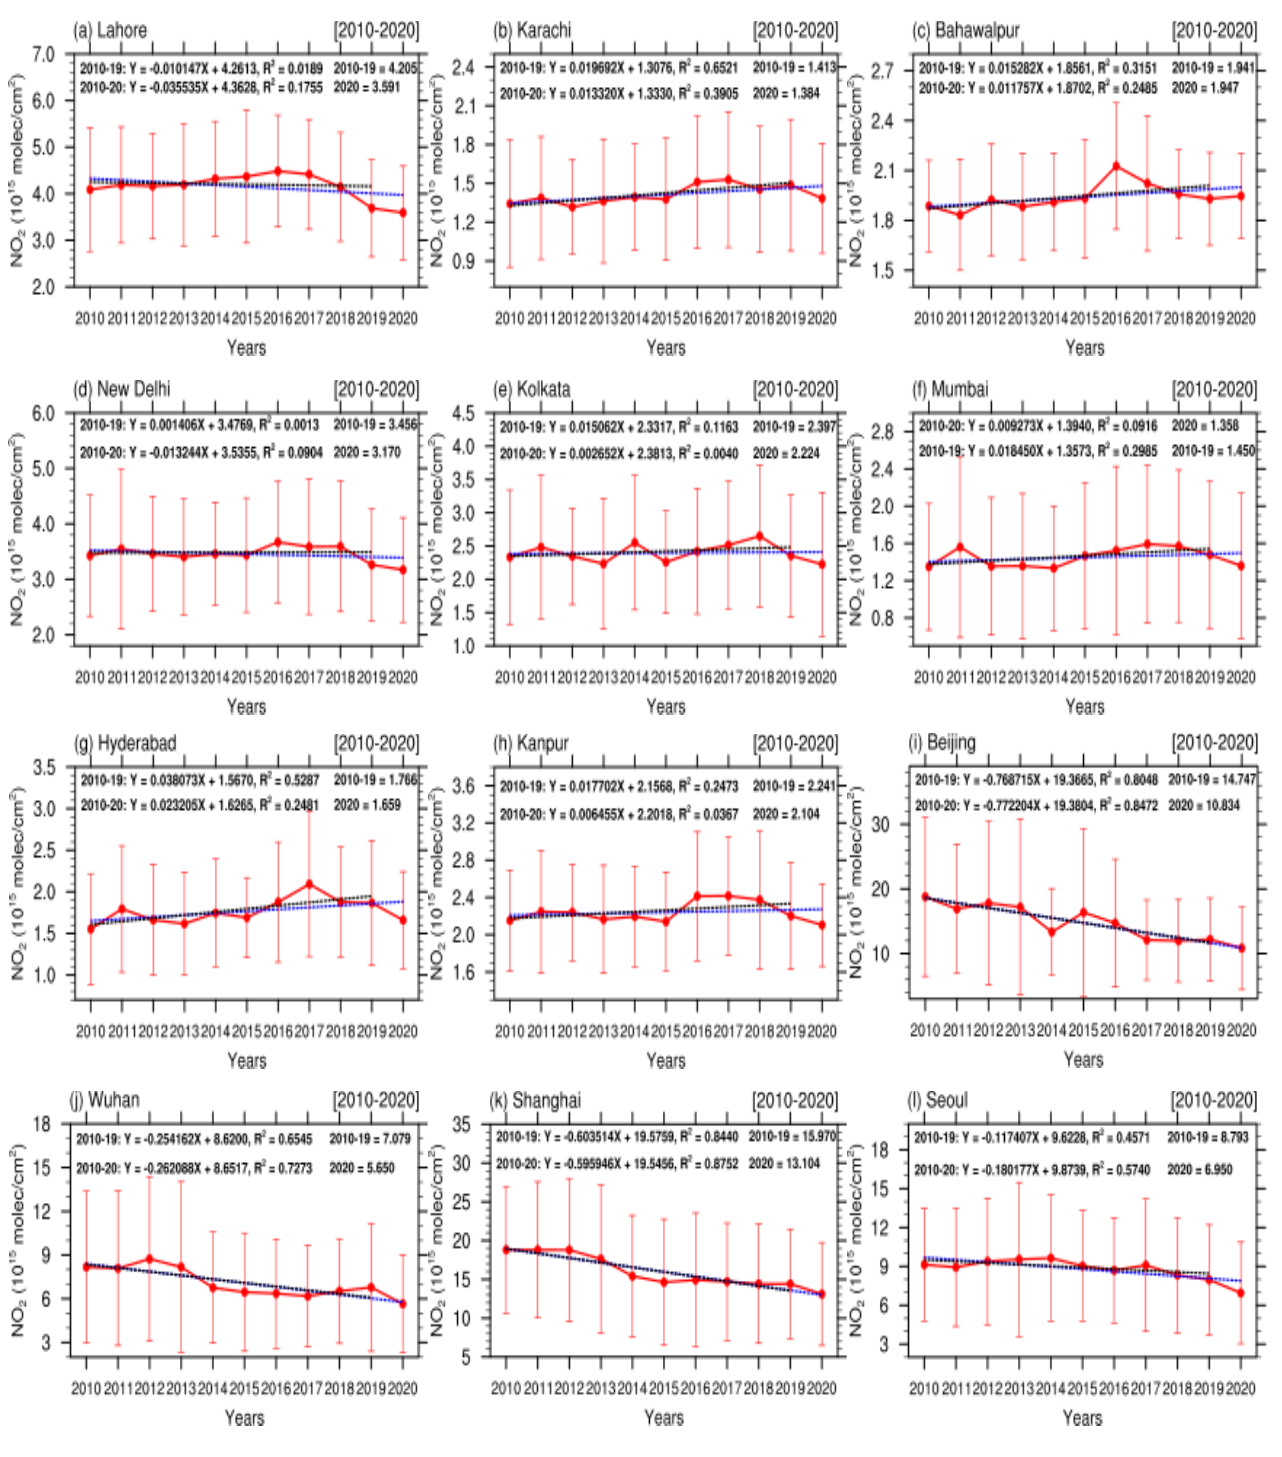
Figure 4. Annual trends in NO 2 concentrations during 2010–2020 in ( a ) Lahore, ( b ) Karachi, ( c ) Ba- hawalpur, ( d ) New Delhi, ( e ) Kolkata, ( f ) Mumbai, ( g ) Hyderabad, ( h ) Kanpur, ( i ) Beijing, ( j ) Wuhan, ( k ) Shanghai, and ( l ) Seoul. The red lines represent NO 2 concentrations during the years, the black dotted lines represent trends in NO 2 during 2010–2019, and the blue lines during 2010–2020. Error bars represent standard deviations.